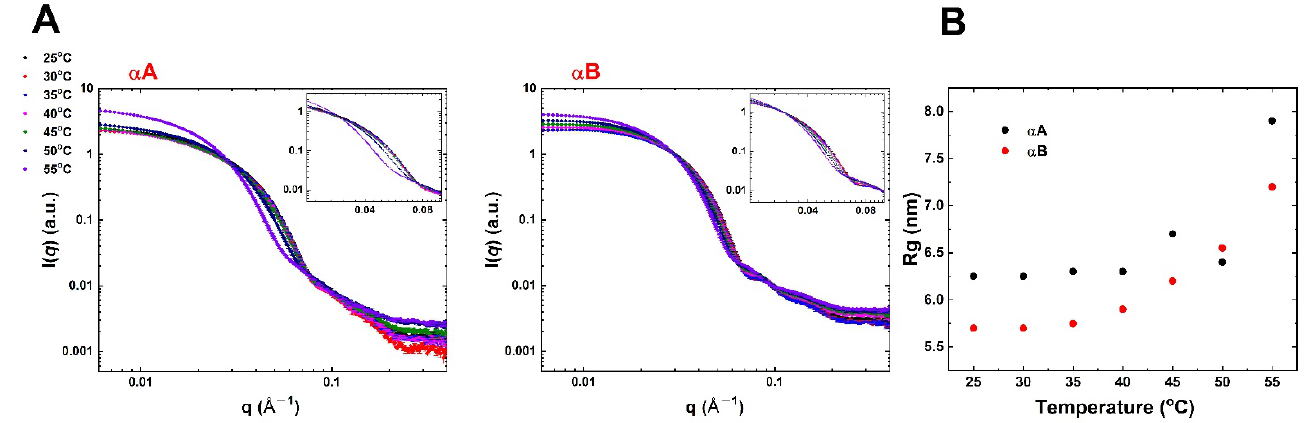
Figure 4. ( A ) SAXS profile of α -crystallins at various temperatures. Upon increasing temperature, the scattering pattern significantly changed in q range between 0.03 and 0.1 Å − 1 (inset), indicating that morphologies changed with increasing temperature. ( B ) Evolution of the radius of gyration ( R g ) of α -crystallins as a function of various temperatures. The effects of temperature rising on the structure of α -crystallins are reflected in the increase in R g